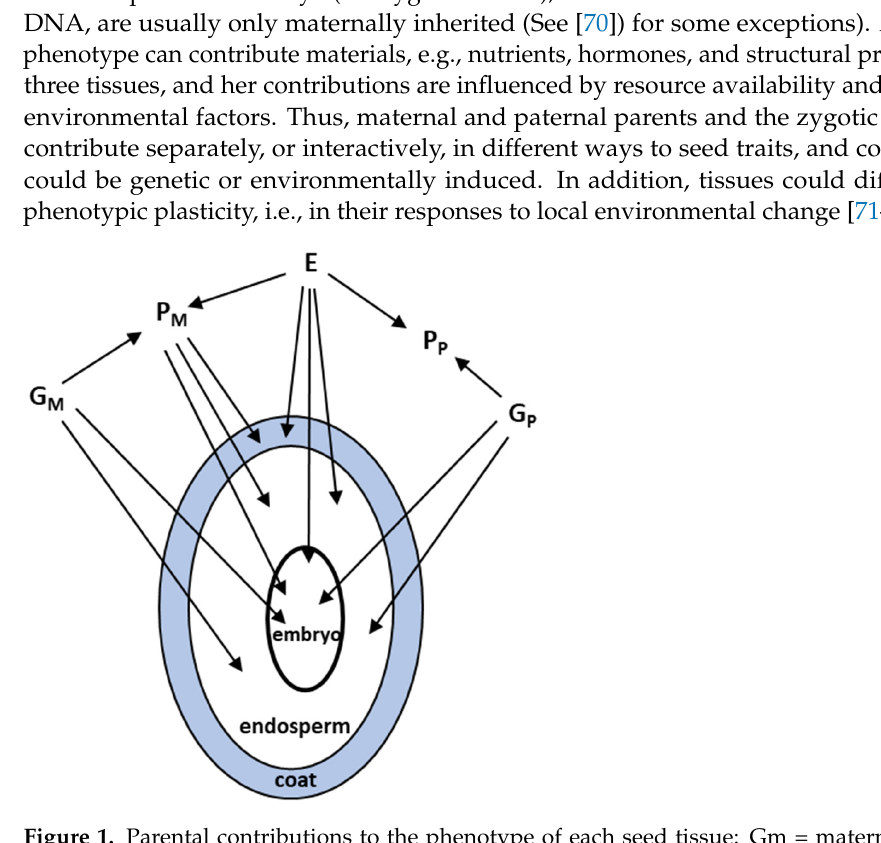
Figure 1. Parental contributions to the phenotype of each seed tissue: Gm = maternal direct genetic, Gp = paternal direct genetic, E = direct environmental, Pm = maternal phenotypic, and Pp = paternal phenotypic.